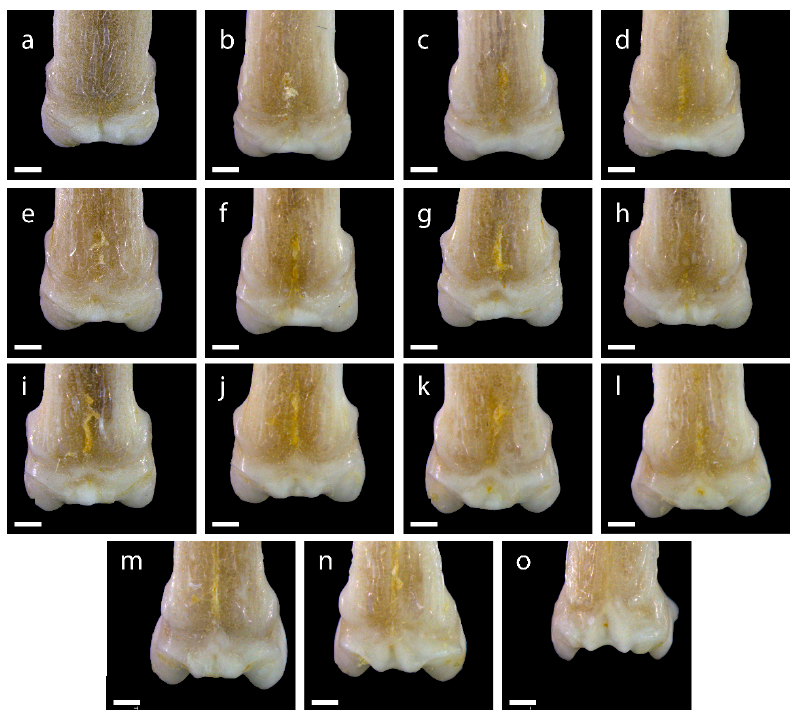
Figure A7. Microscopic images of the anterior view of the pinnules of P. bichir PO2. The images ( a – o ) correspond to the 1st, 2nd, 3rd, 4th, 5th, 6th, 7th, 8th, 9th, 10th, 11th, 12th, 13th, 14th, and 15th pinnules, respectively. Scale bars = 1 mm.